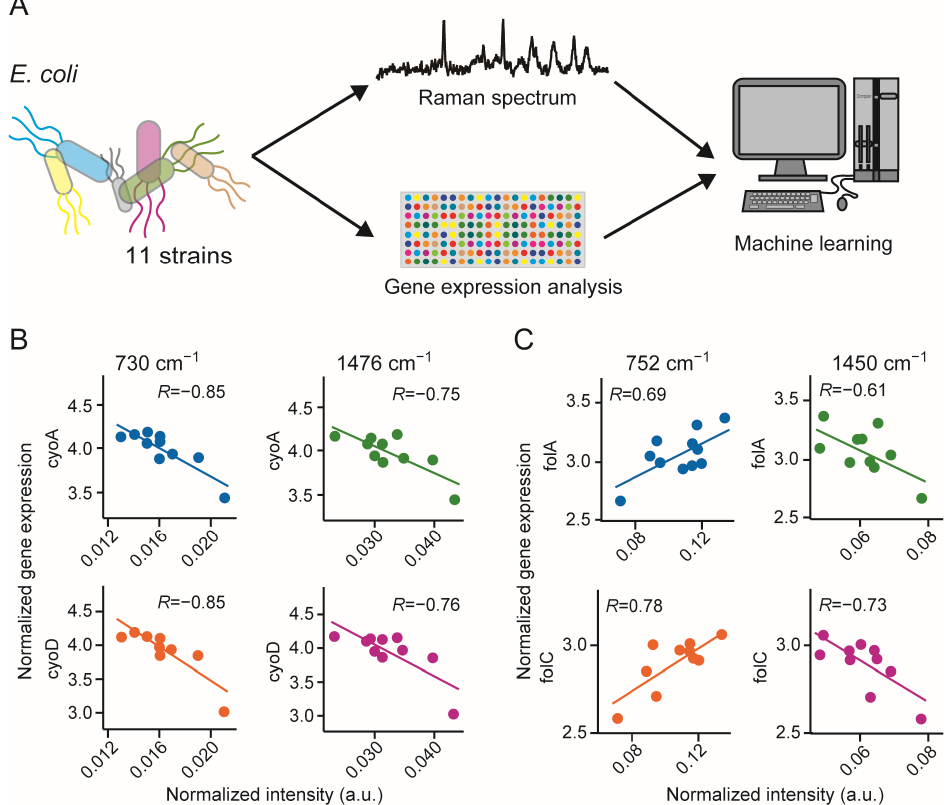
Figure 4. Gene expression prediction using Raman spectra. ( A ) Schematic illustration of the concept of gene expression prediction. ( B ) Relationship between Raman peak intensities at 730 cm − 1 (left) or 1476 cm − 1 and guantile-normallized gene expression of cyoA (top) or cyoD (bottom). ( C ) Relationship between Raman peak intensities at 752 cm − 1 (left) or 1450 cm − 1 and gene expression of folA (top) or folC (bottom). Reproduction from reference [51].